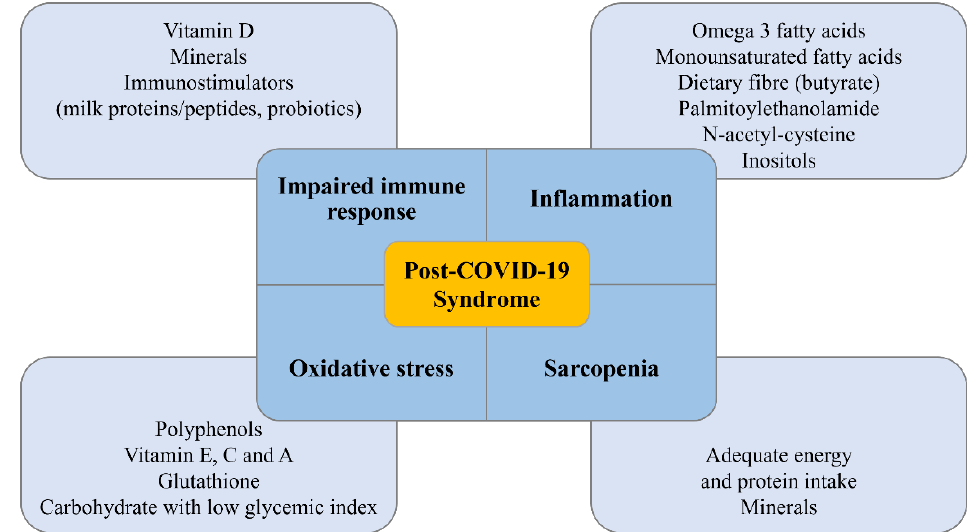
Figure 1. Dietary recommendations for patients with post-COVID-19 syndrome.